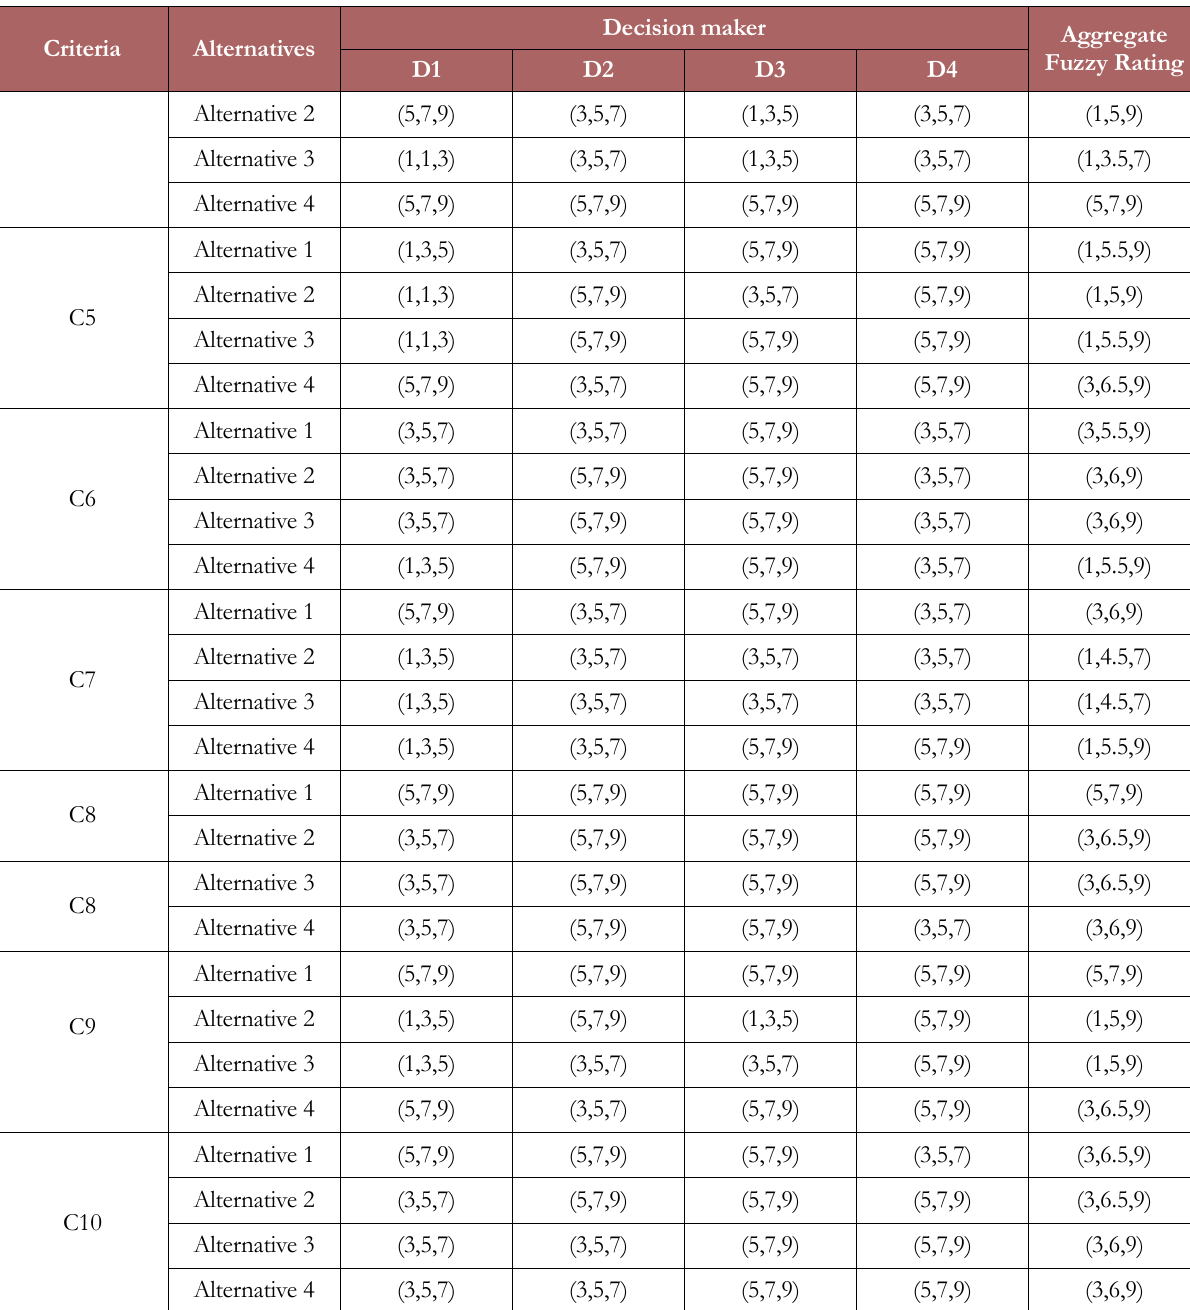
Table 9. Aggregate fuzzy weights for